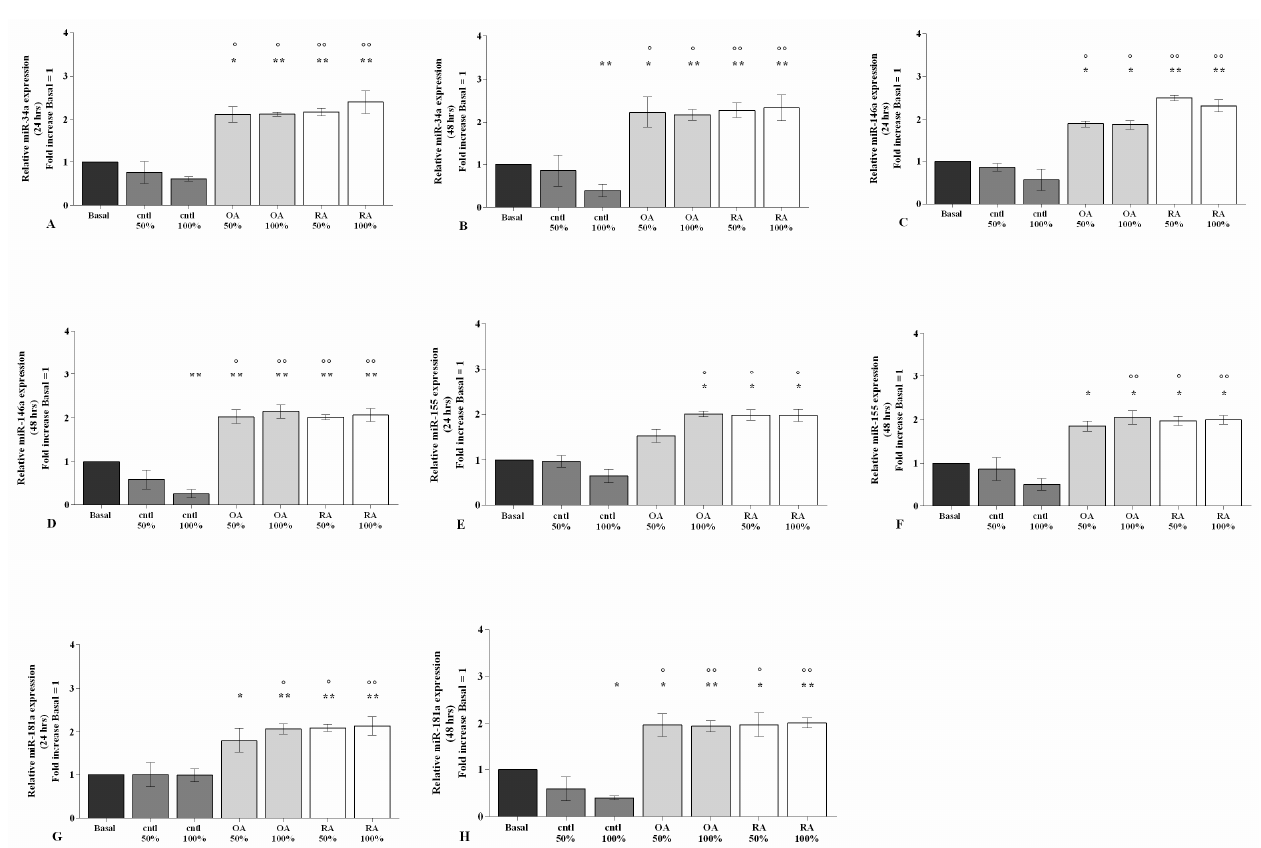
Figure 5. SF regulation on miRNA. Human osteoarthritic (OA) chondrocytes were incubated for 24 h and 48 h with 50% and 100% SF derived from patients with OA, rheumatoid arthritis (RA), or controls. ( A – H ) Expression levels of microRNA ( miR ) -34a , miR-146a , miR-155 , and miR-181a analyzed by quantitative real-time PCR. The gene expression was referenced to the ratio of the value of interest and the value of basal condition, reported equal to 1. Data were represented as mean ± SD of triplicate values. * p < 0.05, ** p < 0.01 versus basal condition. ◦ p < 0.05, ◦◦ p < 0.01 versus control